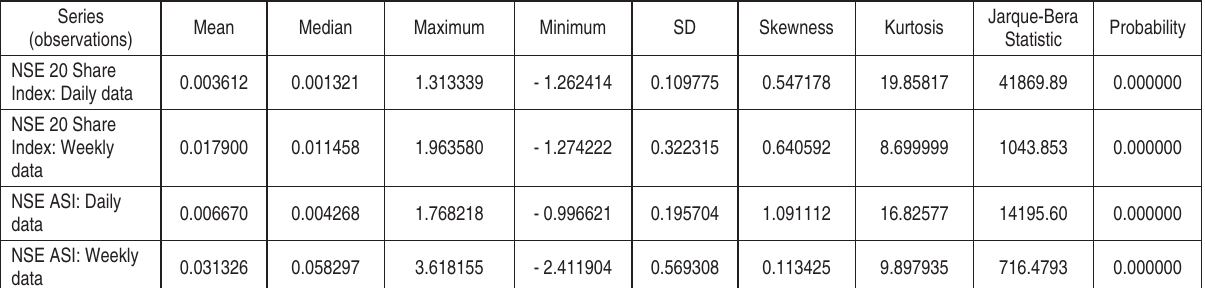
Table 2. Results of the descriptive statistics